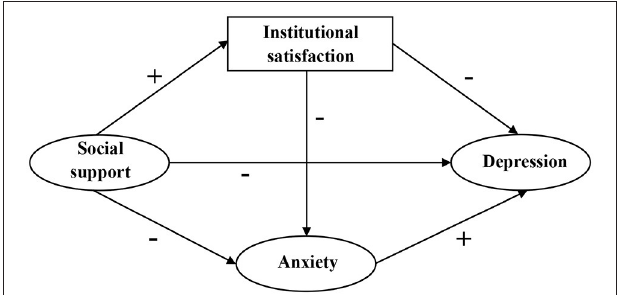
FIGURE 1 | Theoretical model and hypotheses.